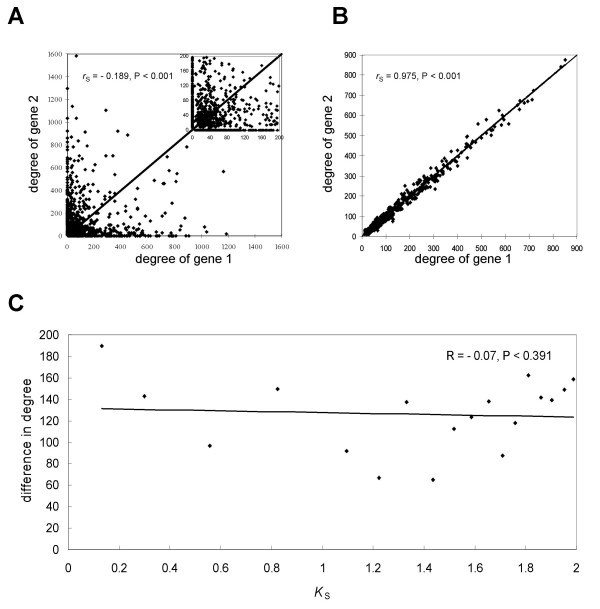
Asymmetric divergence in gene expression. (A) Plot of degree of one gene versus degree of another gene for 1,547 duplicate gene pairs with KS < 2 (inset shows pairs with both degrees below 200). (B) The same plot after numerical simulation of symmetric divergence with equal probability of loss and gain of coexpressed partners (P = 0.5). (C) The relationship between the difference in degree and time since duplication (measured by KS) for a pair of duplicate genes. Each point represents an average value for 40 duplicate gene pairs.